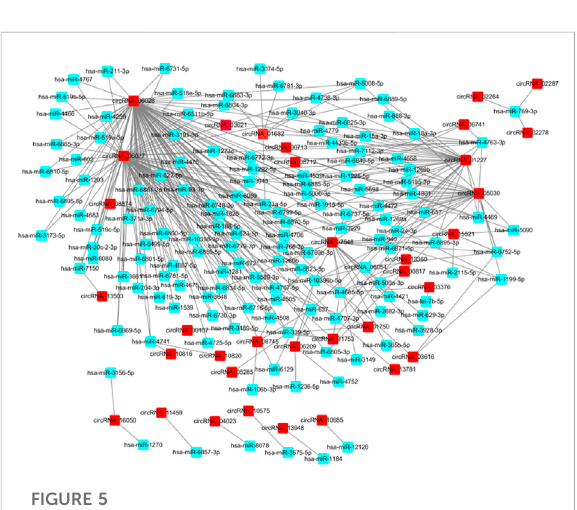
FIGURE 5 Network of the DE circRNA-DE miRNA